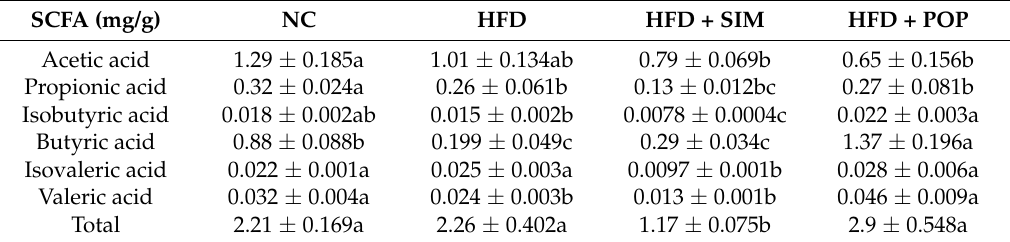
Table 1. Effects of POP on SCFA production in HFD-fed obese